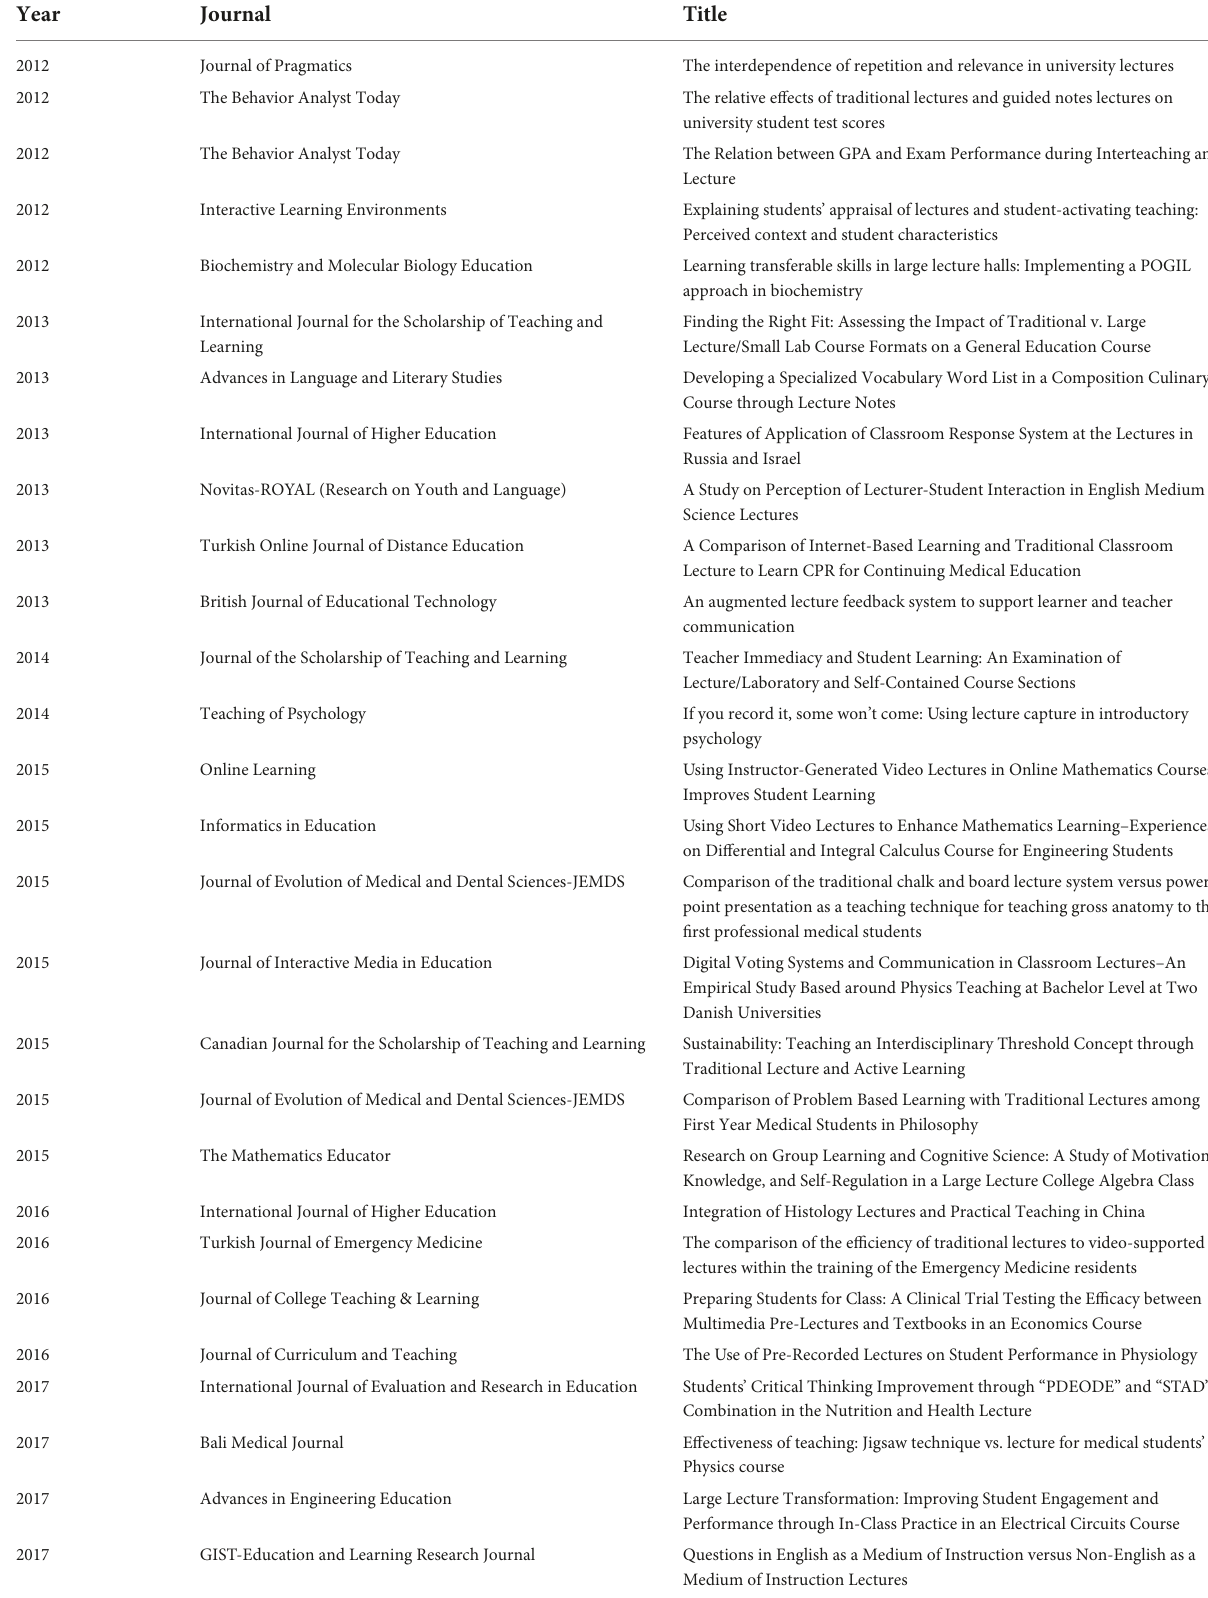
TABLE 1 Selected articles in chronological